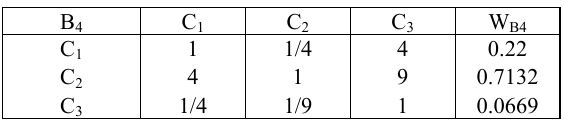
Table 5. The pairwise comparison matrix C 1-3 –B